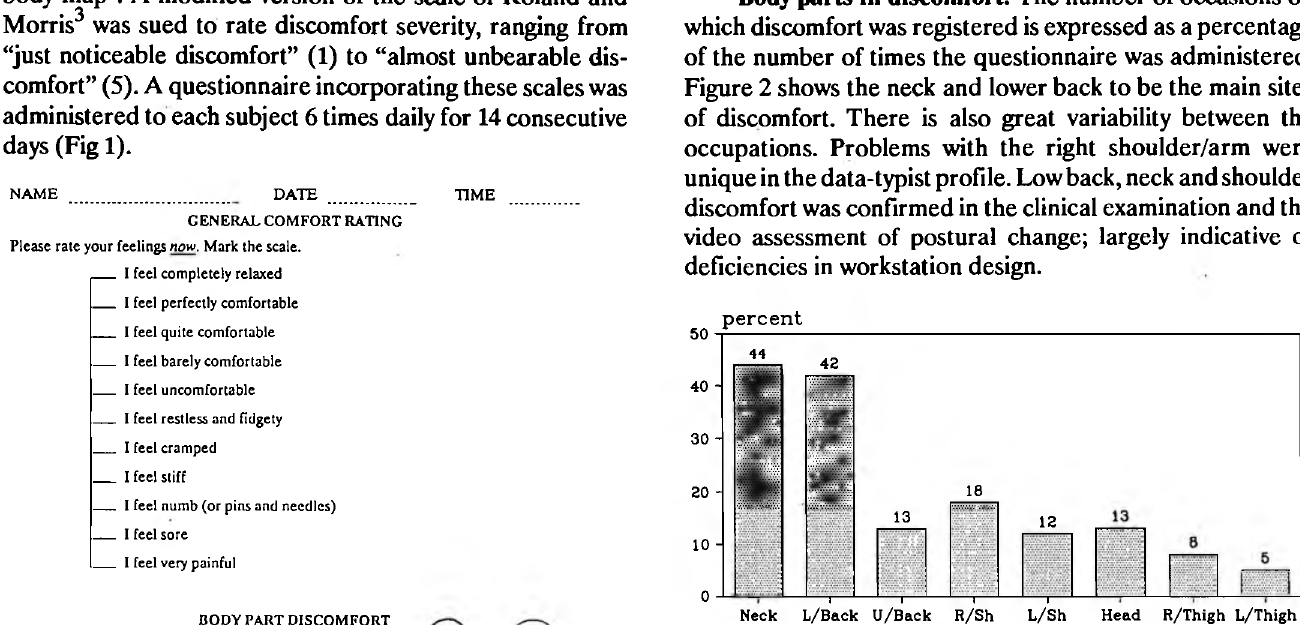
Figure 2. Body parts in